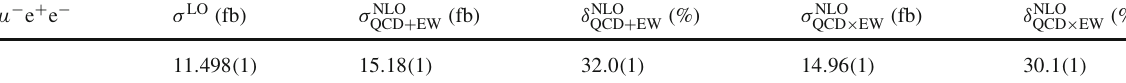
are given. The cross sections are expressed in fb while the relative cor- rections are given in percent. The integration errors of the last digits are provided in parentheses